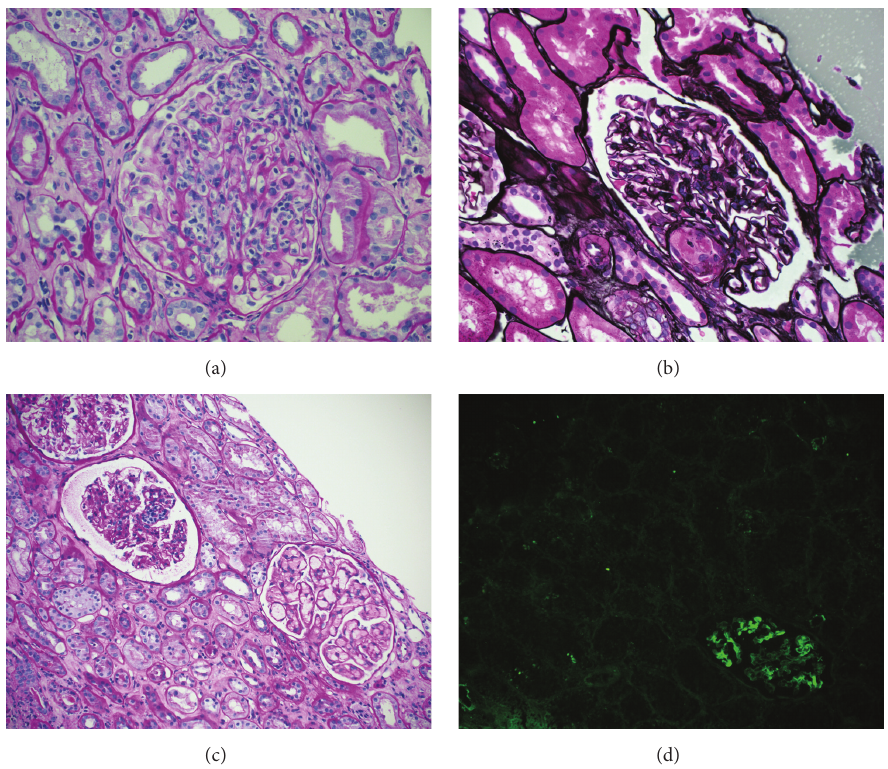
Figure 1: Kidney biopsy findings: (a) transplant glomerulitis with infiltrating mononuclear inflammatory cells within the capillary loops, second biopsy (PAS, magnification × 200); (b) glomerulus with a thrombus involving the vascular pole, second biopsy (Jones, magnification × 200); (c) glomeruli showing persistent transplant glomerulitis and thrombotic microangiopathy, fourth biopsy (PAS, magnification × 100); (d) immunofluorescence microscopy showing C4d mesangial deposition without peritubular capillary staining (magnification ×